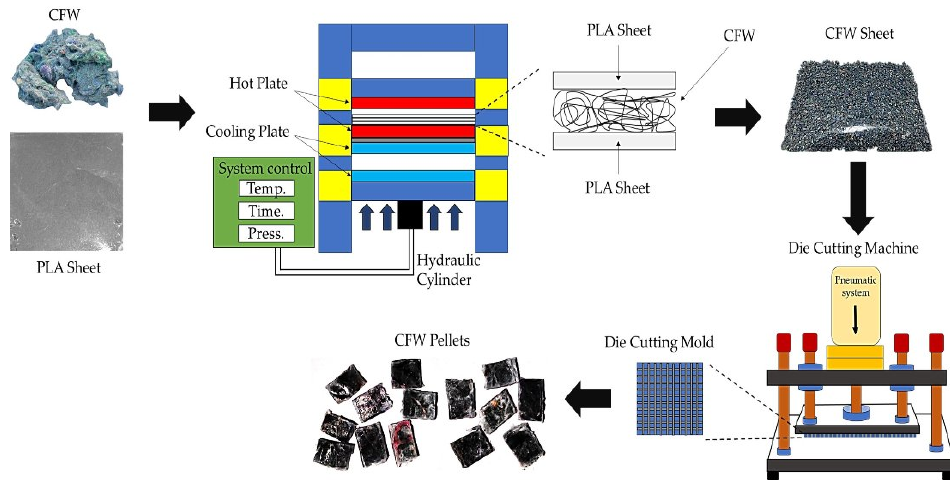
Figure 11. Schematic of the CFW pellet